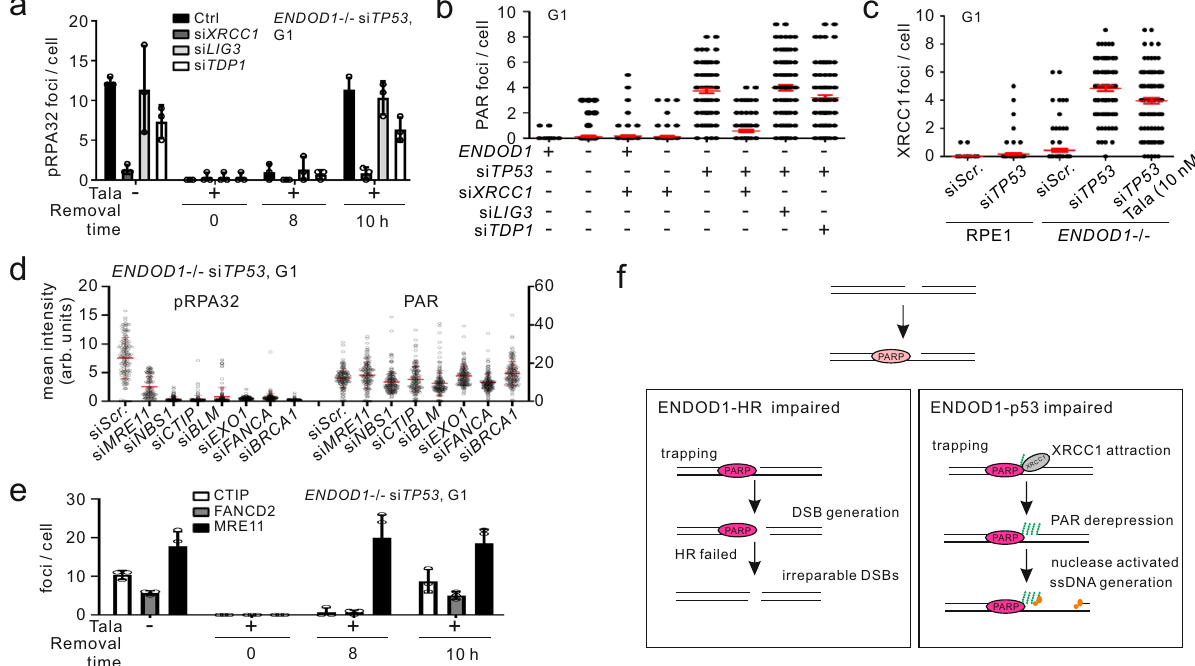
Fig. 6 SSBR and HR machinery provides key signals for ssDNA production. a Quanti fi cation of pRPA32 foci in a Talazoparib addition-removal assay with si TP53 treated ENDOD1 − / − cells co-treated with the indicated SSBR siRNAs. 10 nM Talazoparib was added upon siRNA treatment and removed 72 h later (time 0). n = 3 biologically independent samples. Error bars: SEM. b Quanti fi cation of a-PAR foci in G1 serum starved ENDOD1 − / − and control RPE1 cells following treatment with the indicated siRNAs. n = (99-103) × 5 cells (each data point represents the average foci number of 5 cell counts). Red bar: median. Whiskers: SEM. c Quanti fi cation of XRCC1 foci in serum-starved ENDOD1 − / − and control RPE1 cells following si TP53 treatment with or without co- treatment with Talazoparib. n = (99 – 100) × 5 cells (each data point represents the average foci number of 5 cell counts). Red bar: median. Whiskers: